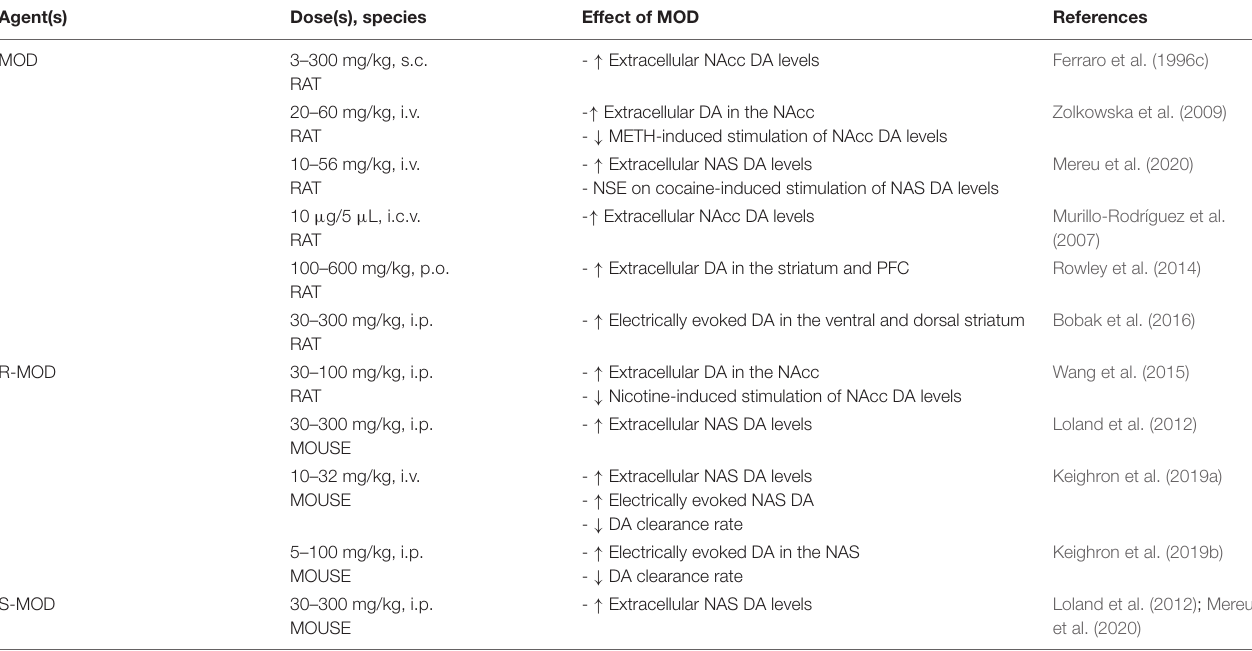
TABLE 2 | Neurochemical actions of